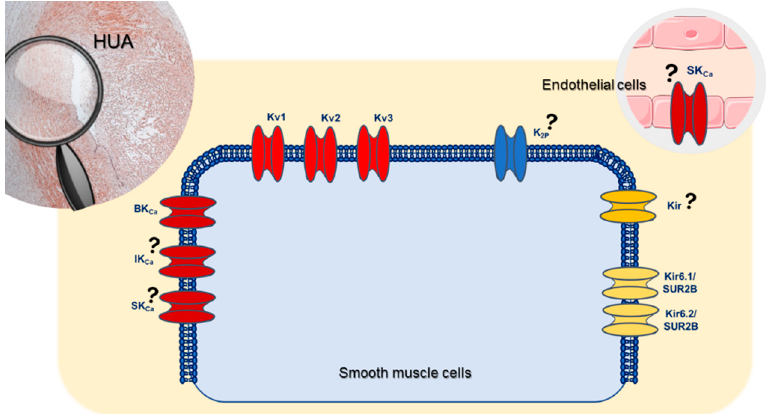
Figure 1. Schematic representation of the K + channels present in human umbilical artery.